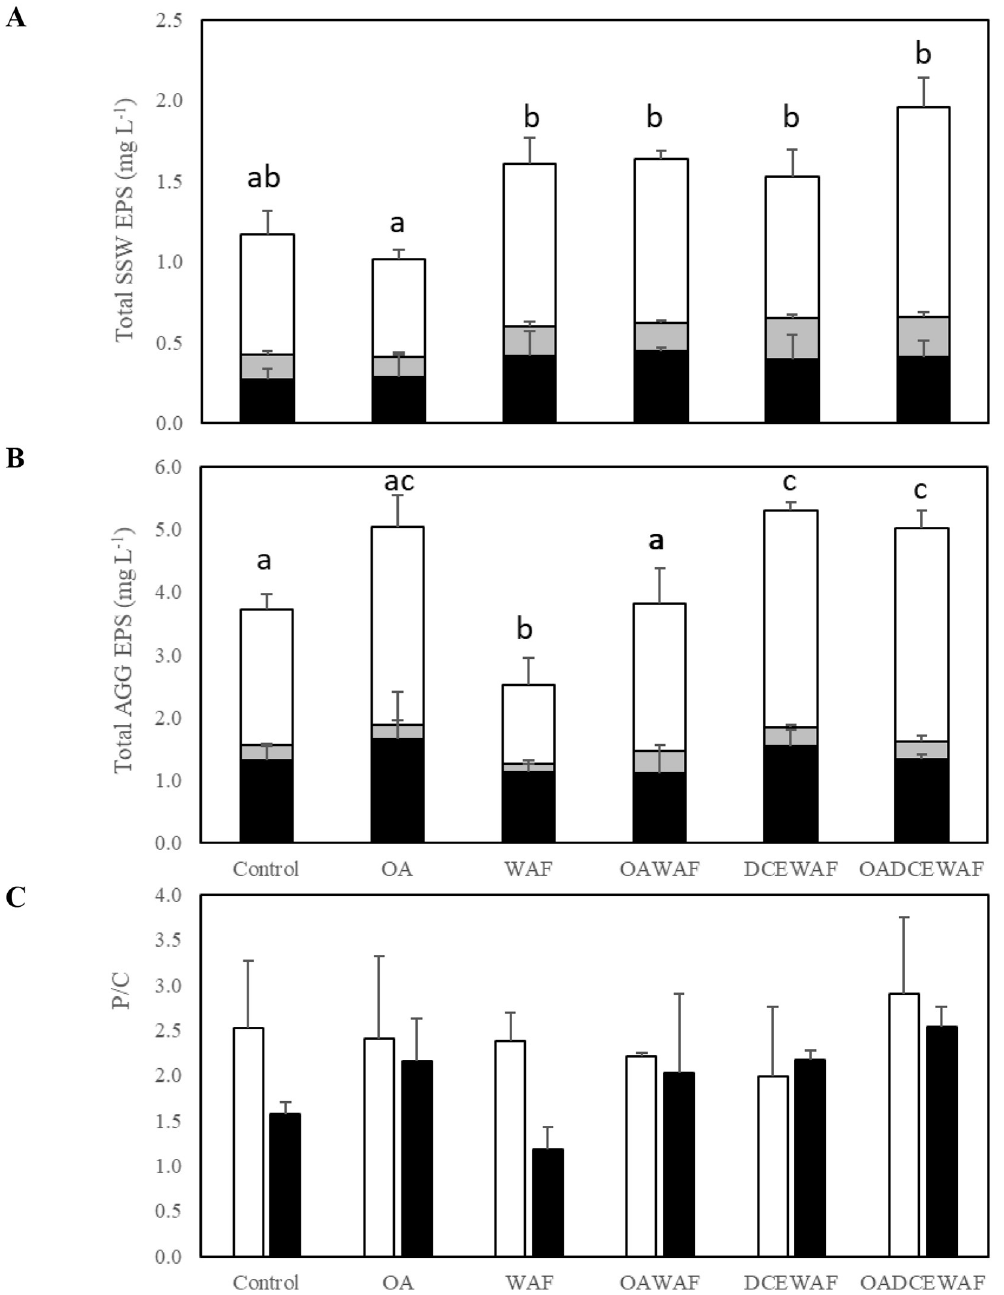
Fig 5. EPS was measured in cultures of T . pseudonana at the end of the roller table experiments. Neutral sugars (black), uronic acids (grey), and proteins (white) are stacked to show the (A) total colloidal EPS concentration in the surround seawater (SSW) and the (B) particulate EPS concentration in the AGGs. (C) Protein/carbohydrate (P/C) ratios of EPS in the SSW (white) and AGGs (black). Error bars show standard deviation of triplicates. Different letters indicate which treatments are significantly ( p < 0.05) different from each